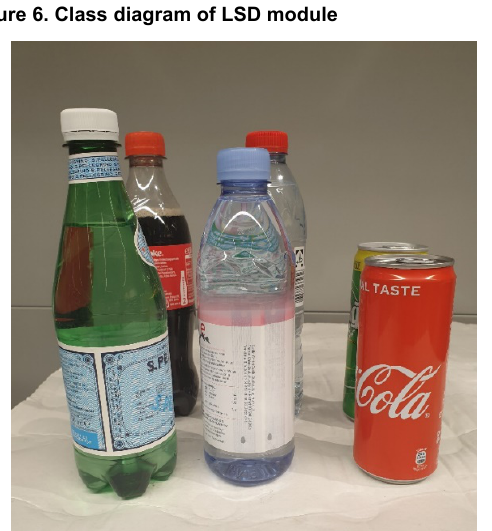
Figure 7. Range of products